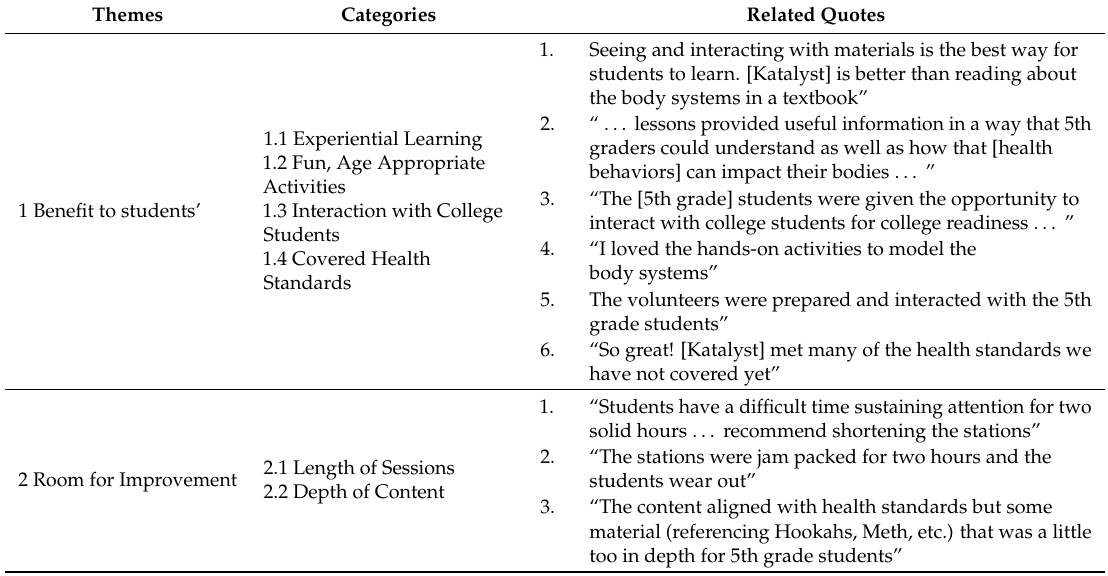
Table 3. Thematic analysis results with associated quotes from fifth-grade school